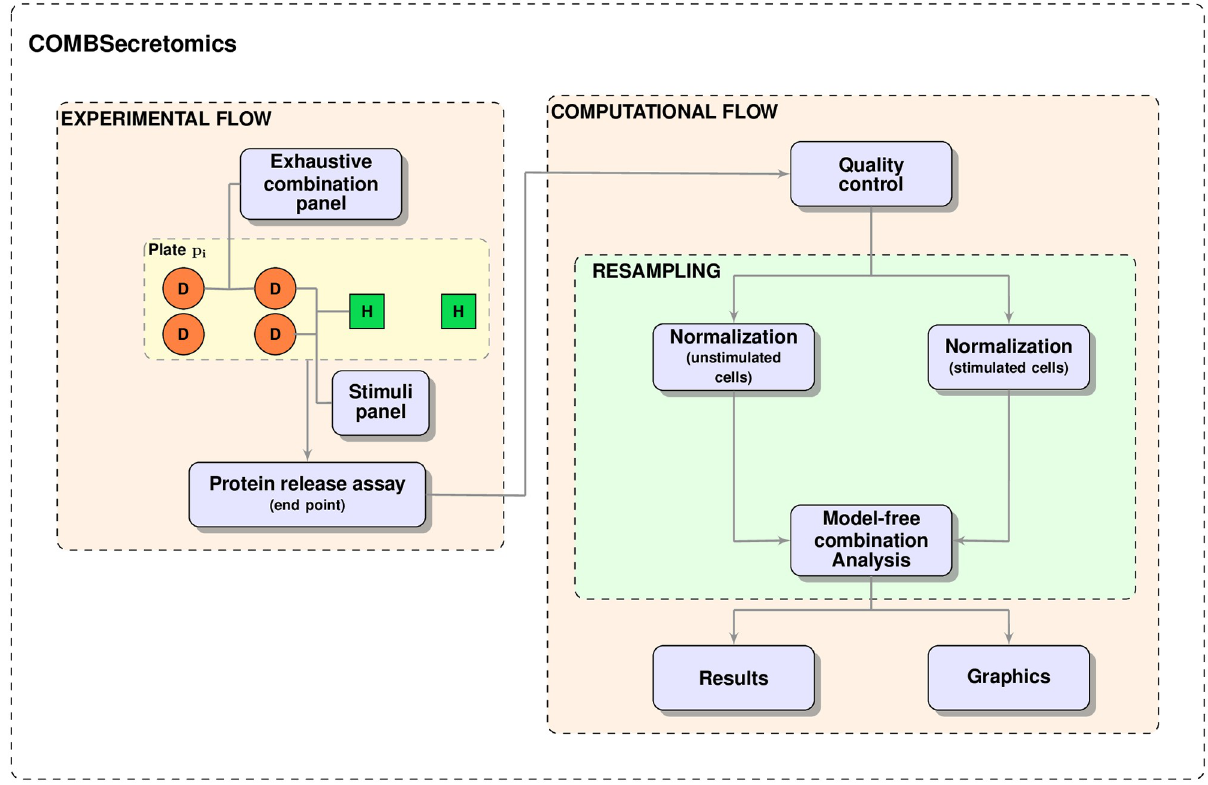
Fig 4. COMBSecretomics flowchart. Experimental flow: disease associated ( D ) and healthy ( H ) cells are treated and stimulated in parallel on the same experimental plate p . An exhaustive combination panel is used for treating D cells, while a stimuli panel is employed for both D and H cells. An end i point protein release assay of any sort can be used provided that it gives values proportional to the corresponding protein concentrations. Computational flow: a series of subsequent computational steps are employed for processing the protein release measurement values. Firstly, quality control procedures are employed. Secondly, protein release differences for stimulated and unstimulated cells are normalized per plate p i . Then two model-free combination analysis methods are employed using the normalized protein release differences. Finally, non-parametric resampling statistics are used to quantify uncertainty for the obtained combination analysis results. Graphic and text files with all results are created and saved automatically.